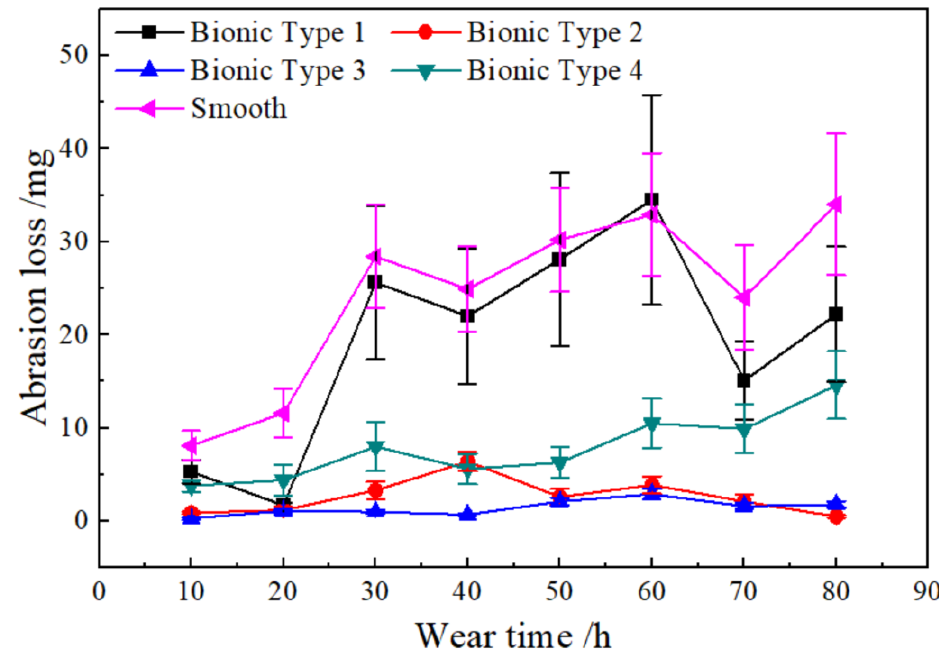
Figure 7. Temporal evolution of wear